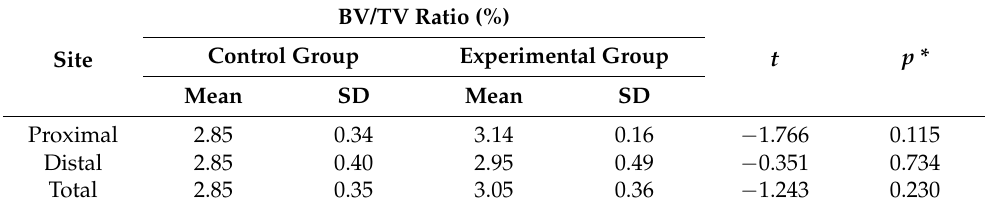
Table 1. Comparison of the bone volume/tissue volume (BV/TV) ratio (%) between the experimental and control groups.